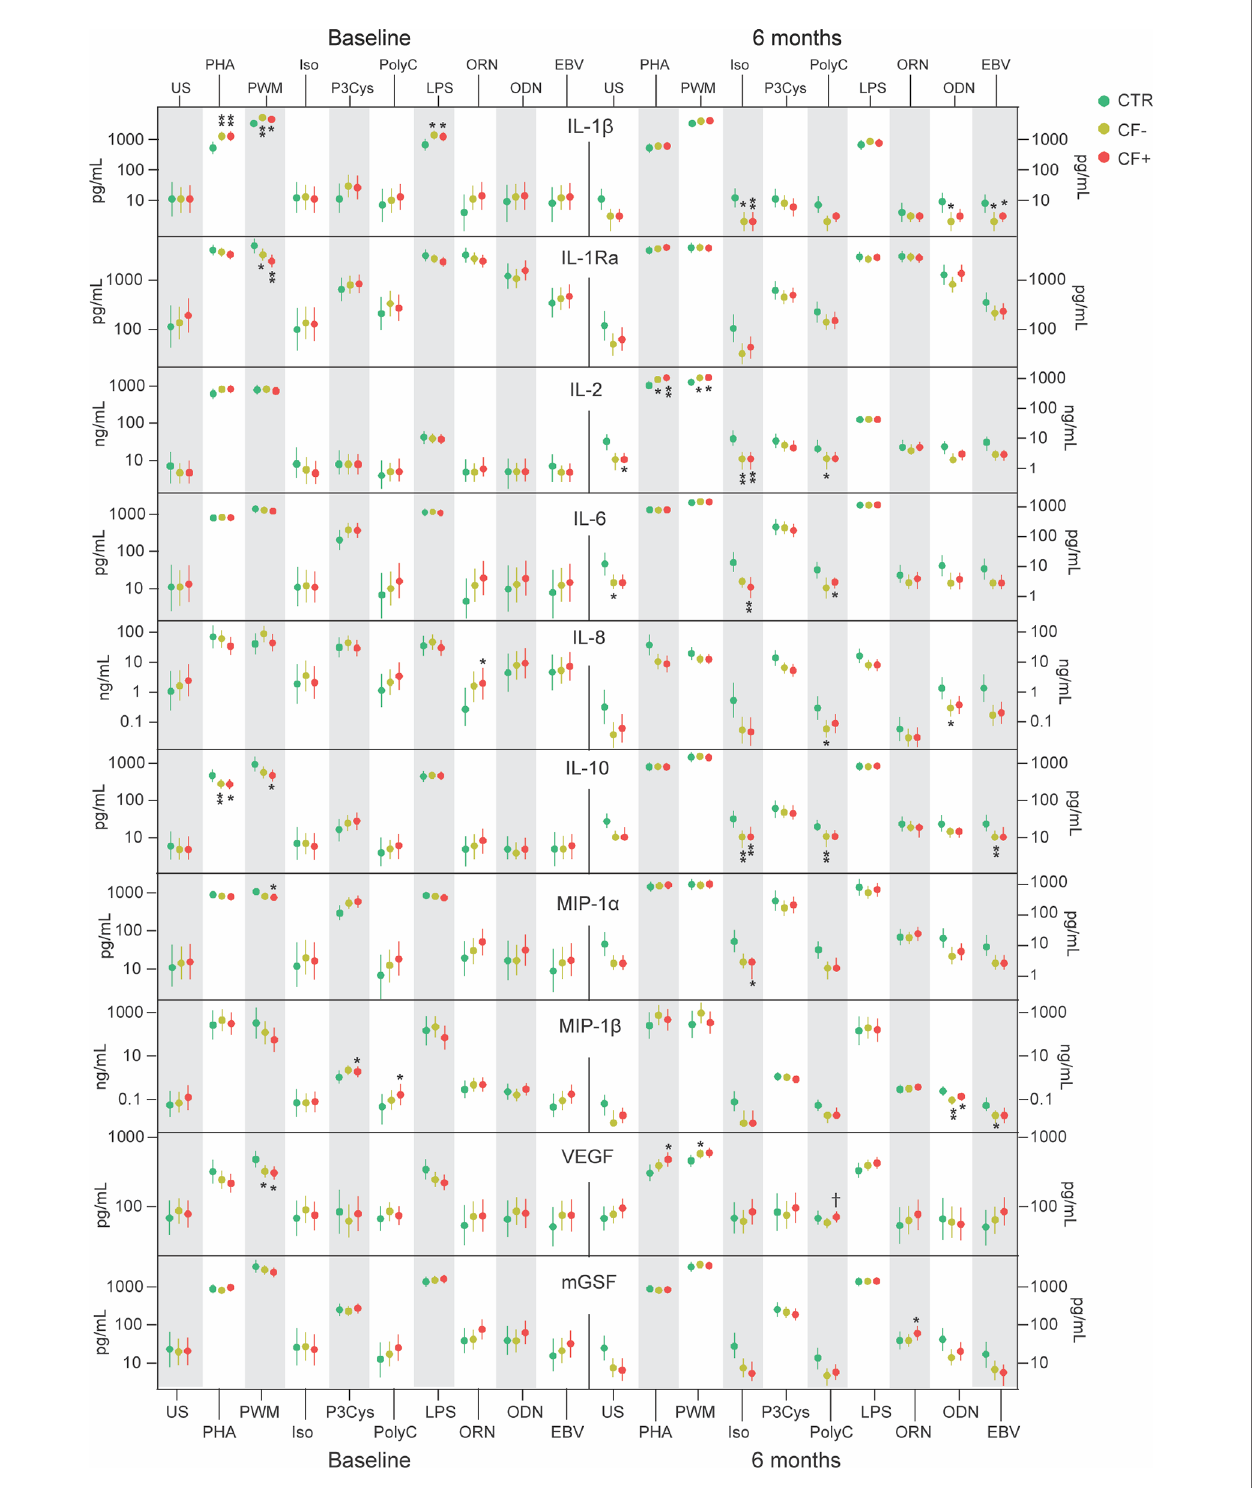
FIGURE 1 | Supernatant levels of IL-1 b , IL-1Ra, IL-2, IL-6, IL-8, IL-10, MIP-1 a , MIP-1 b , VEGF and mGSF in cell cultures of PBMC from healthy controls (CTR) and EBV-patients with and without chronic fatigue (CF+ and CF-, respectively) at baseline and after 6 months. *p<0.05, **p<0.01, CF+ and CF- vs HC. † p<0.05, CF+ vs